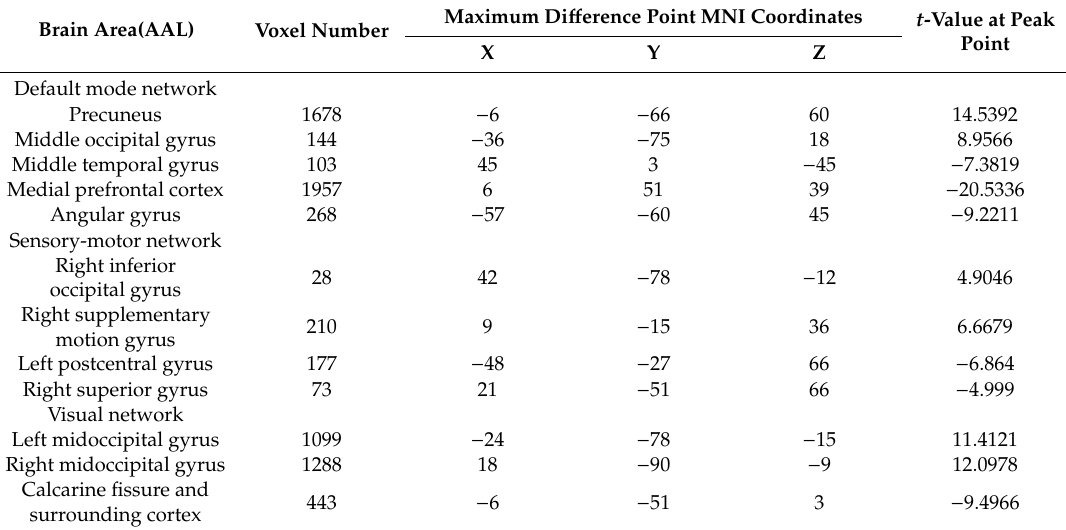
Table 2. Comparison of brain network between tai chi chuan (TCC) group and walking